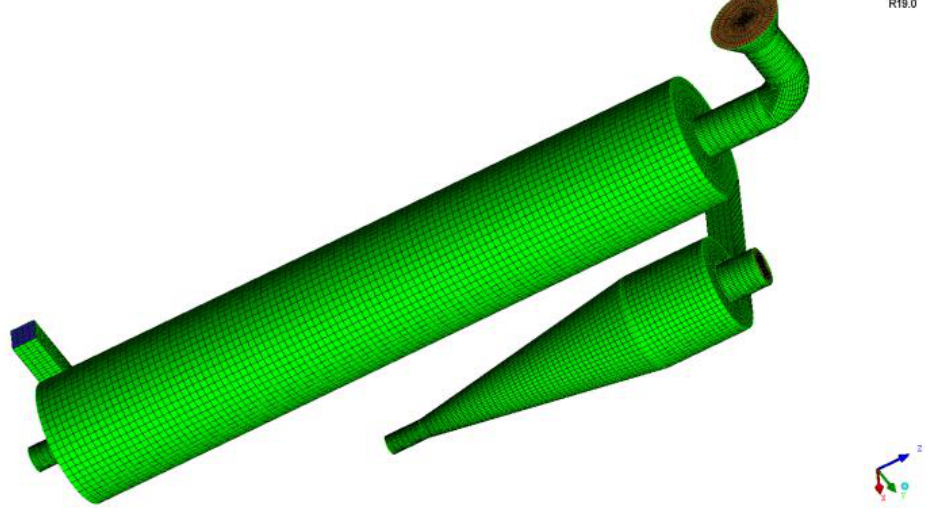
Figure 3. Mesh Figure 3. Mesh generation.